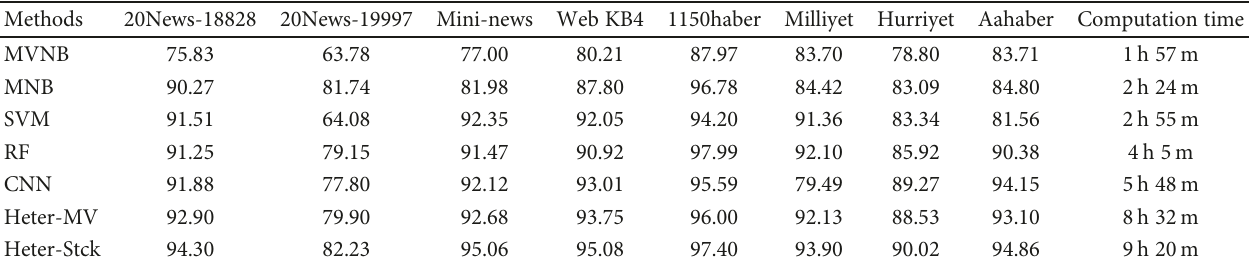
Table 5: The list of classi fi cation accuracies of single classi fi ers and heterogeneous ensemble systems with majority voting and stacking integration strategies on datasets represented with TF-IDF and the average of Word2vec vectors.